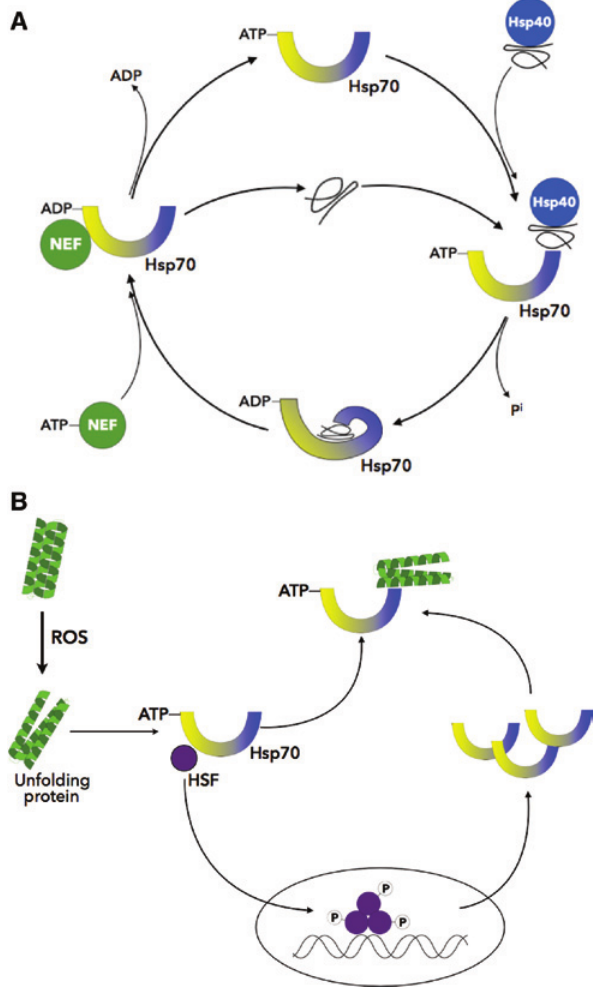
Figure 2: Chaperone activity and regulation of